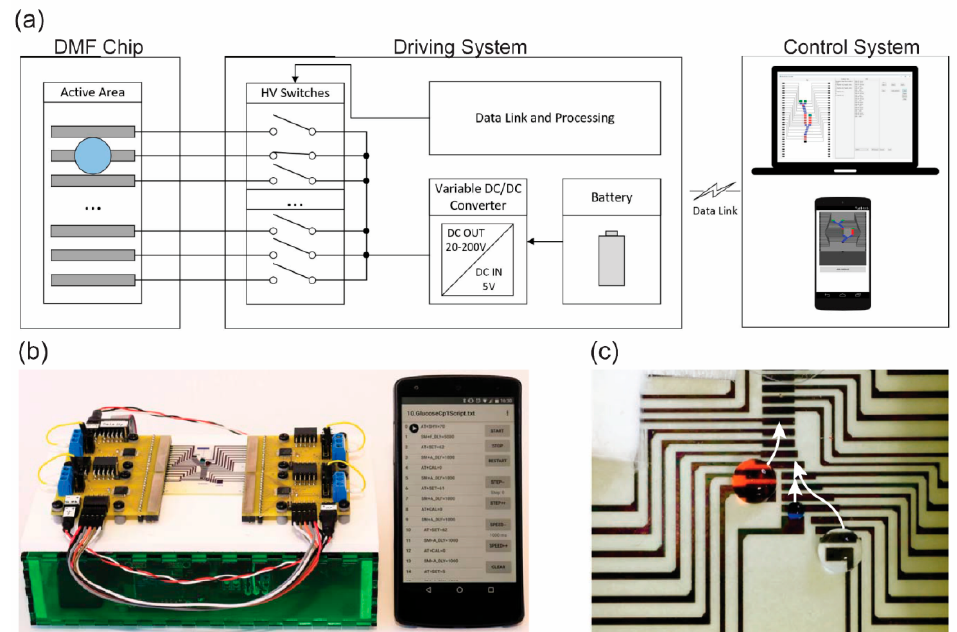
Figure 16. ( a ) Schematic illustration and ( b ) image of the operation system for a p-DMF device. Reproduced with permission from the authors of [27]. Copyright 2017 IEEE. ( c ) A p-DMF chip actuating a droplet by using the operation system. Reproduced with permission from the authors of